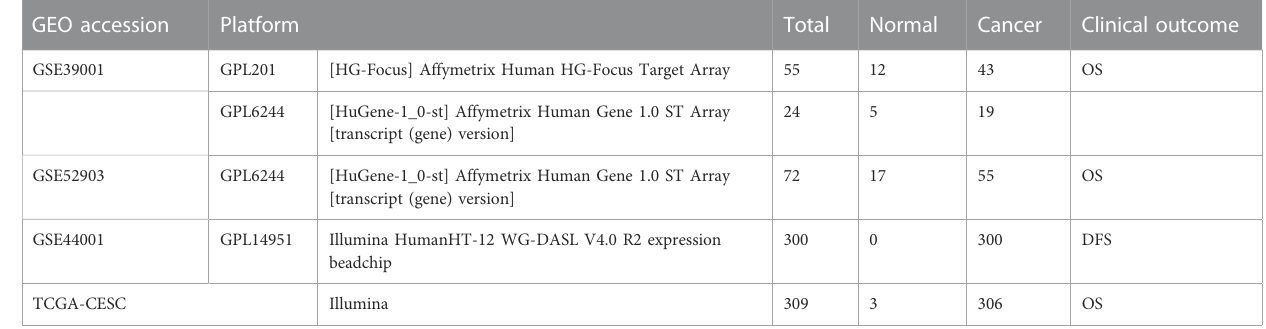
TABLE 1 Overview of details of the datasets.